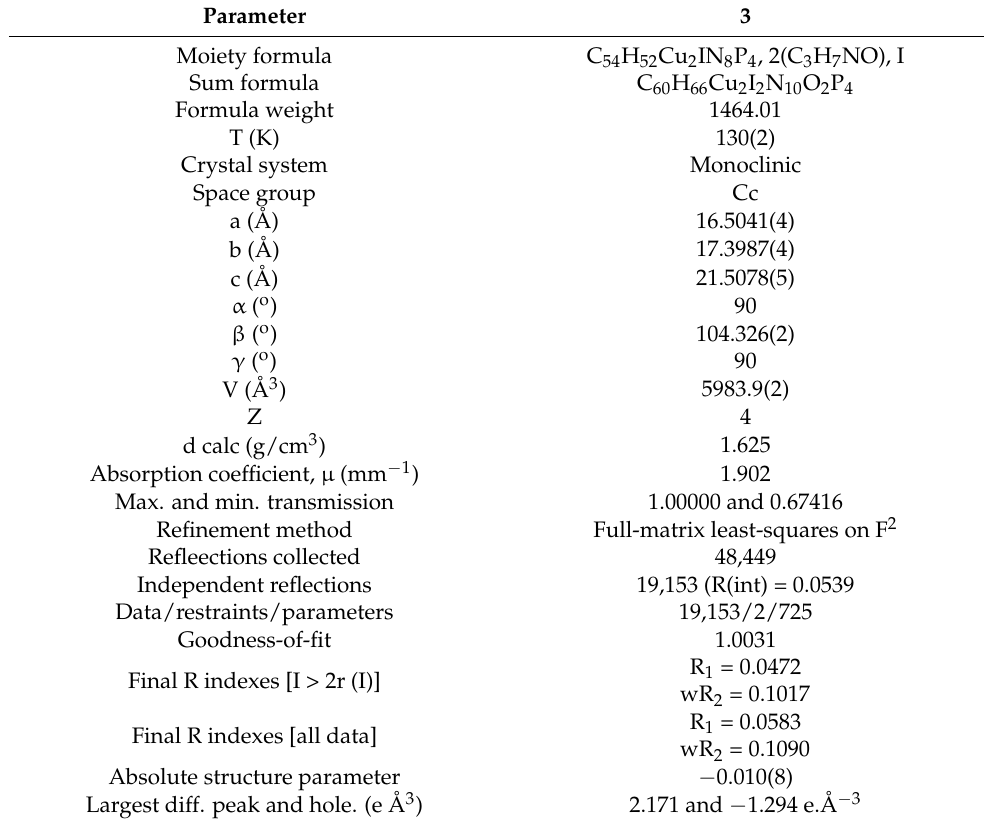
Table 1. Crystal data and structure refinement for complex 3